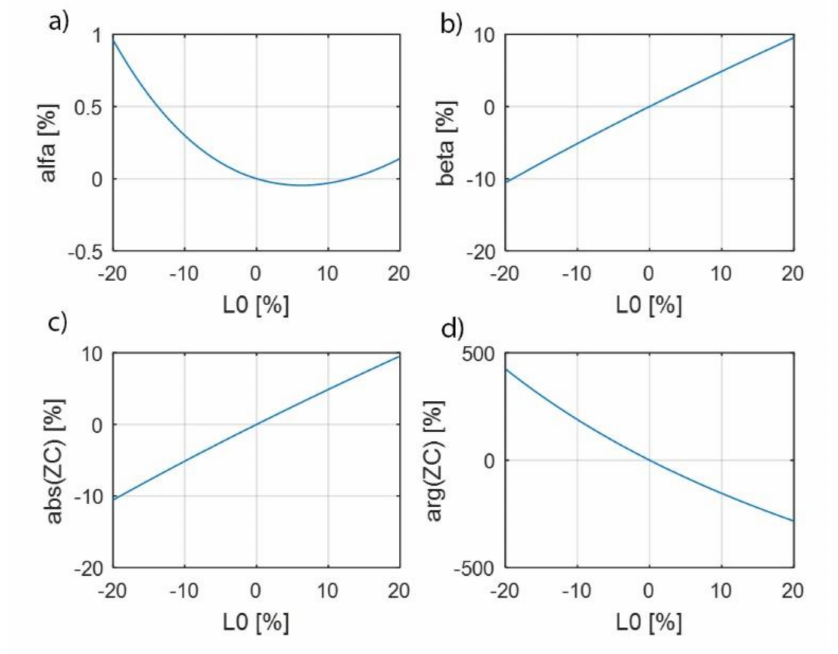
Figure 5. Changes of wave parameters depending on L 0 at f = 100 kHz; ( a ) damping factor α ,